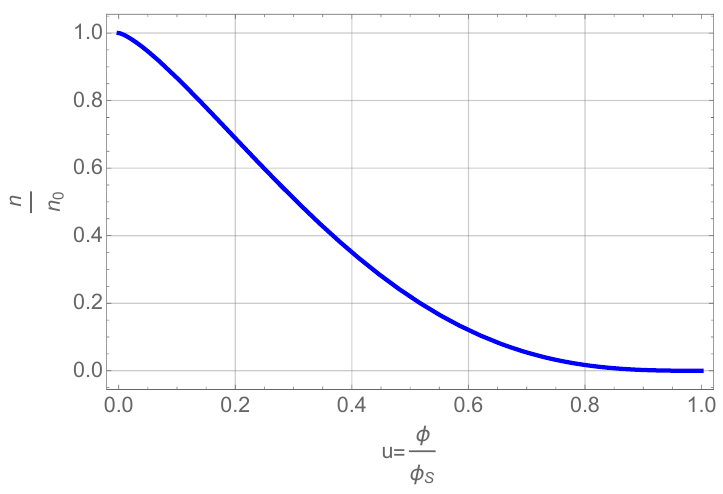
Figure 5. Number density of clusters as a function of normalized volume fraction.